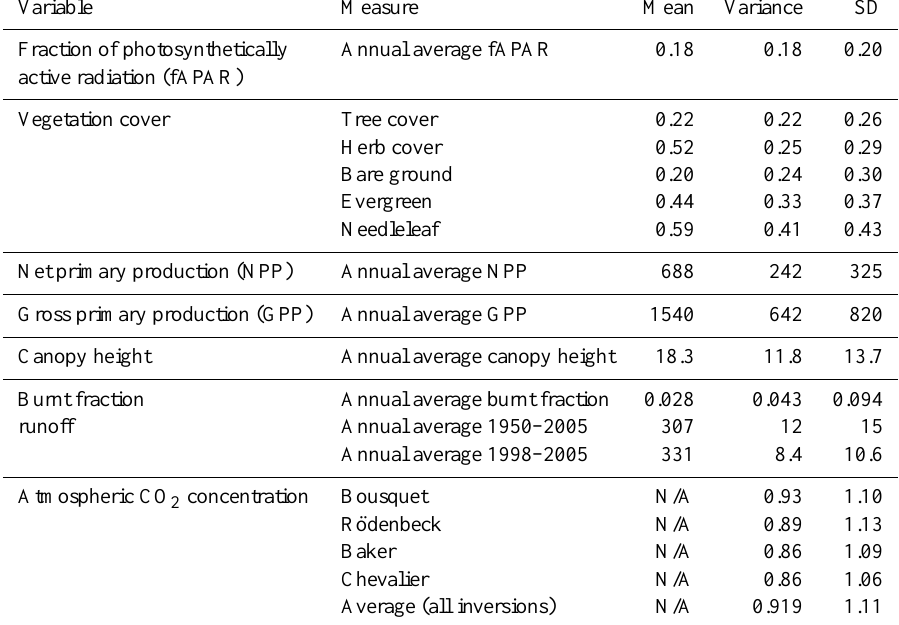
Table 3. Mean, absolute variance (as defined in Eq. 3) and standard deviation (SD) of the annual average values of observations. The variance for most variables is from the long-term mean of the gridded or site data, whereas CO 2 is the variance of the inter-annual